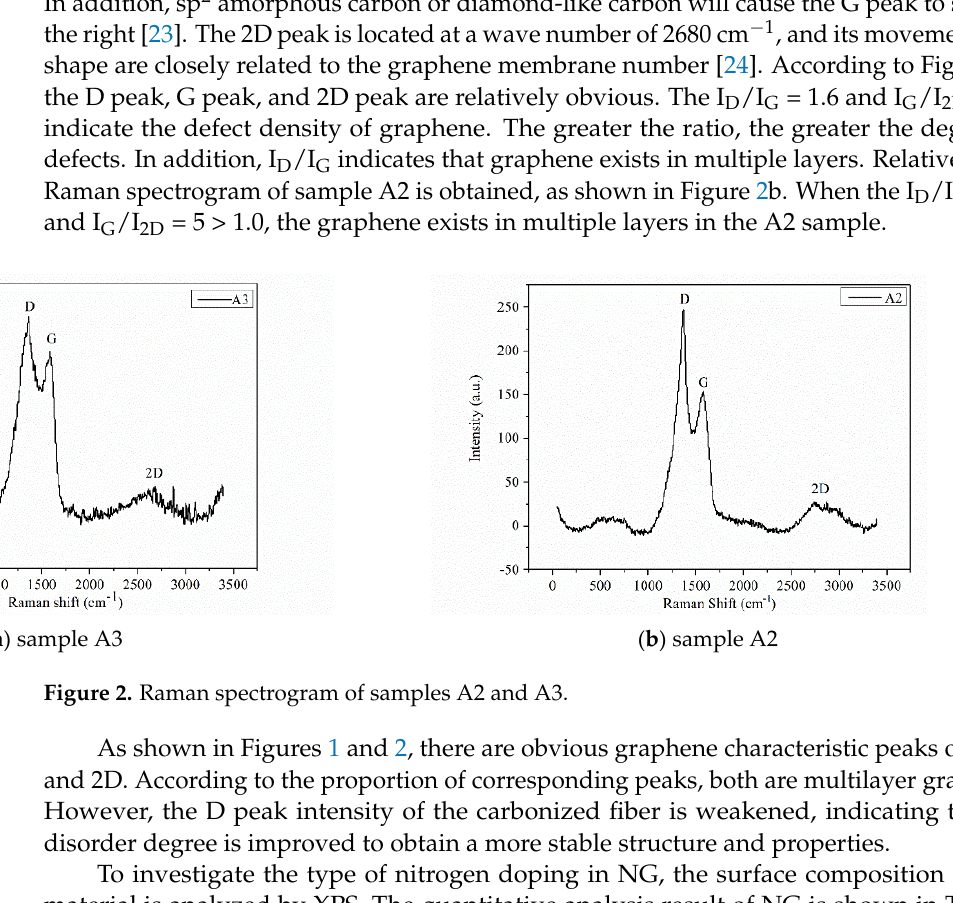
Table 1. Quantitative analysis results of NG.